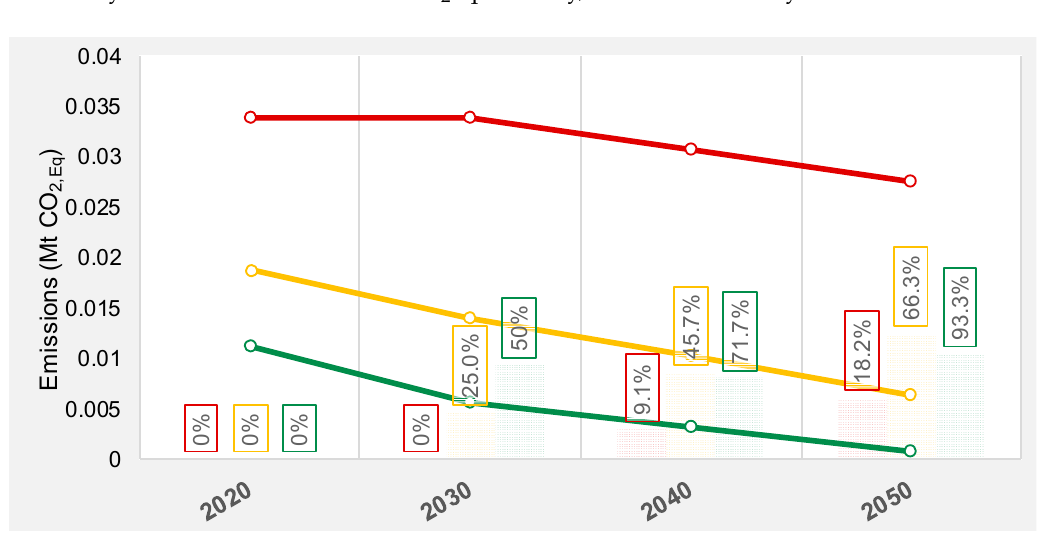
Figure 15. Botanicals global warming potential (GWP) vs. COGs portfolio.